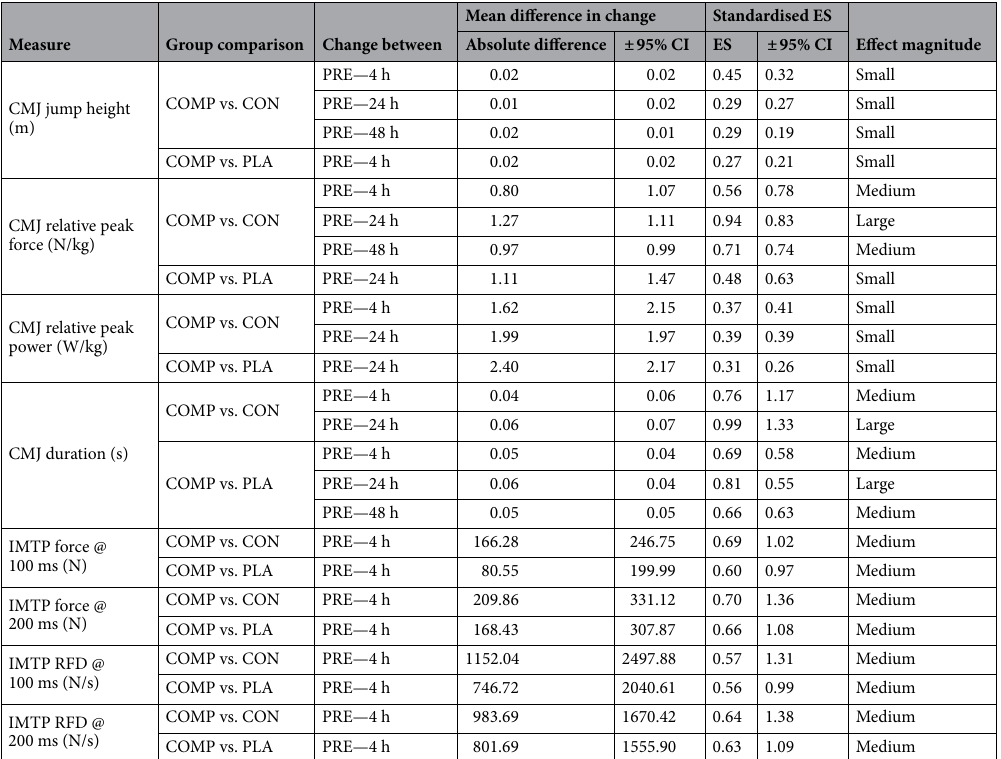
Table 4. Summary of all between-group effects for CMJ and IMTP